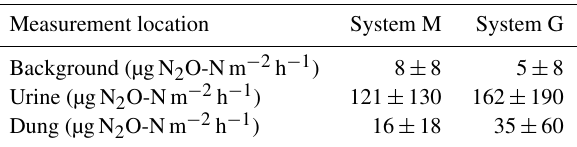
Figure 7. Scatterplot shows the comparison of near-simultaneous fluxes for different sources measured with the fast box on the two pasture systems. The black line indicates the 1 : 1 line. Table 3. Flux measurements using the FB technique (mean ± SD) of background and excreta patches averaged over 20 days follow- ing a grazing phase. Only near-simultaneous measurements in both systems were considered.